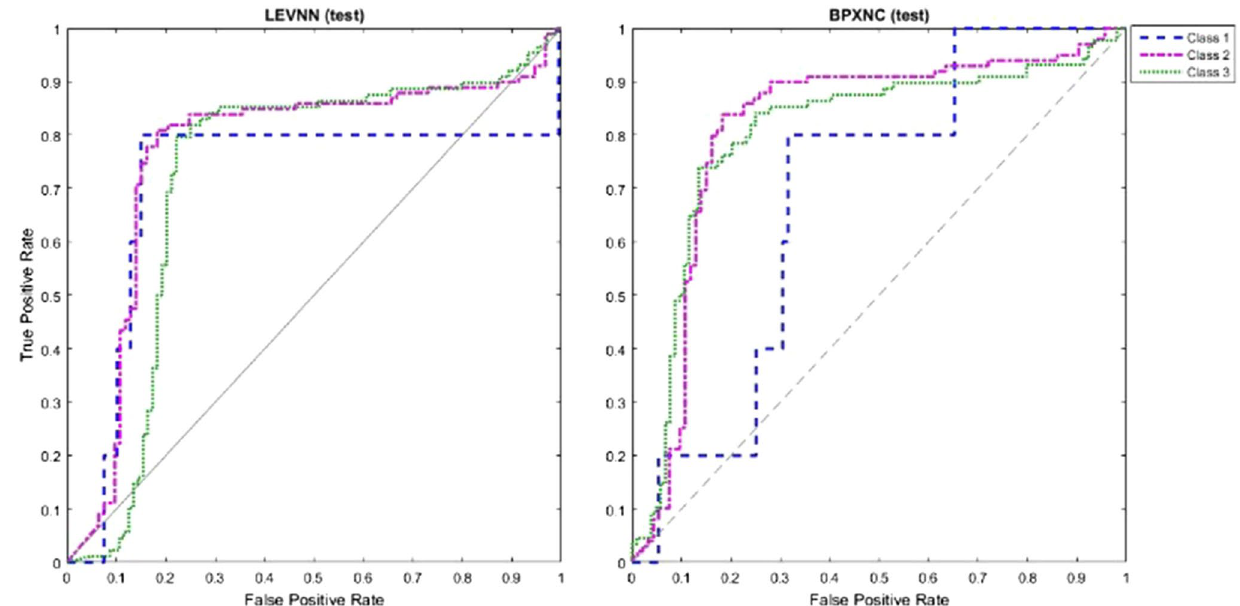
Fig. 12 ROC curve for ANN (testing)